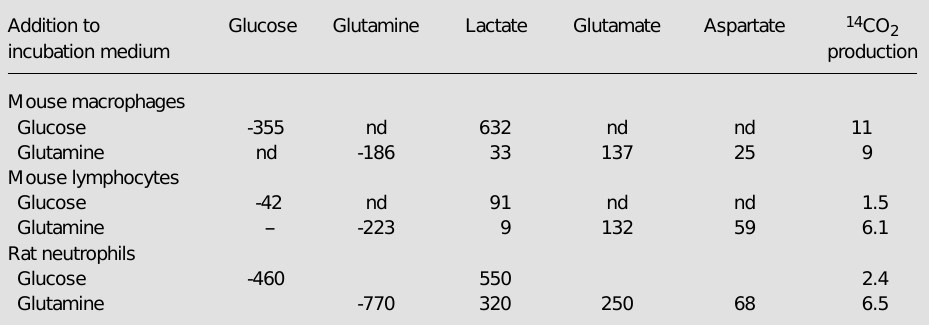
Table 2 - Rates of glucose or glutamine utilization and of lactate, glutamate, aspartate and 14 CO 2 production by isolated incubated mouse macrophages, rat lymphocytes or rat neutrophils. Data are taken from Ardawi and Newsholme (3), Newsholme et al. (5) and Pithon-Curi et al. (6). The negative sign (-) indicates utilization; nd, not